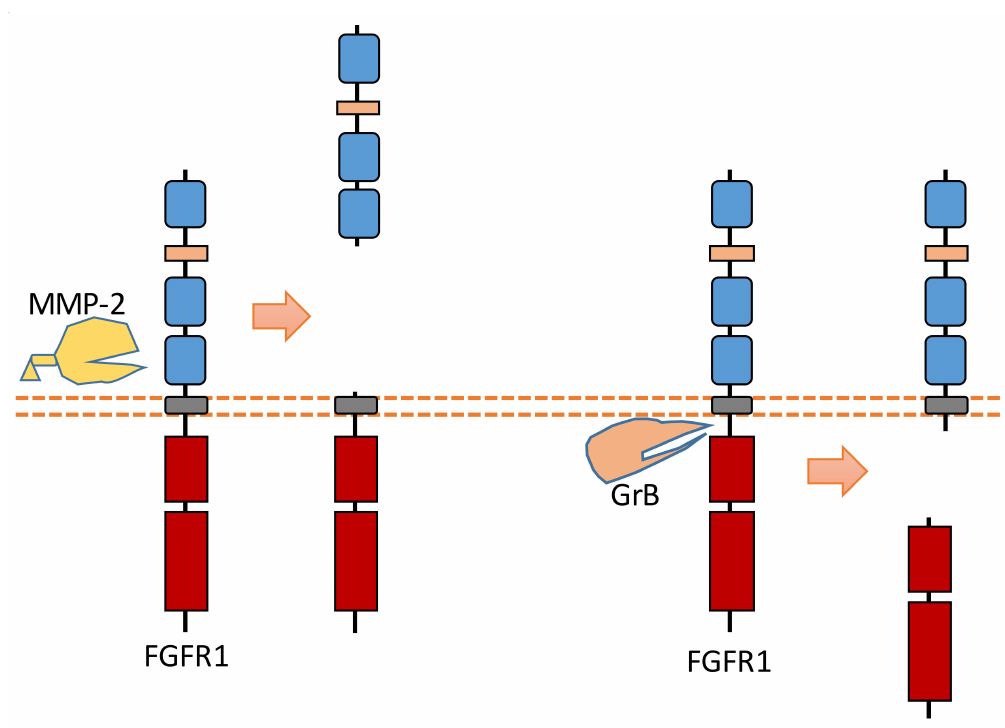
Figure 8. Schematic illustration of proteolytic cleavage in FGFR1.